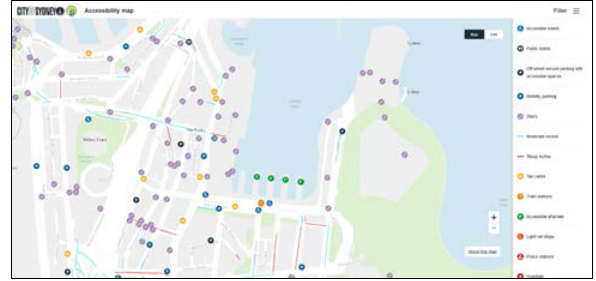
Figure 1. City of Sydney’s Accessibility Map.